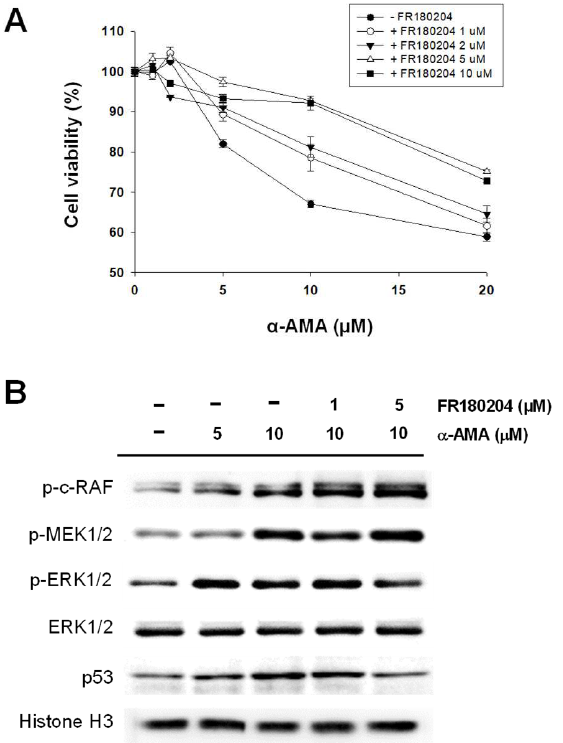
Figure 3. Identification of RAS/RAF/ERK signaling pathway related to the toxicity of α-amanitin (α-AMA) in Huh-7 cells. ( A ) Cell viability assay for α-AMA treatment with ERK1/2 inhibitor. Cell density was 5 × 10 3 cells/well in a 96-well plate. The viability of Huh-7 cells was detected by CCK-8 reagent after α-AMA and ERK1/2 inhibitor treatment for 24 h. The data are presented as the means ± SEM ( n = 3). ( B ) Immunoblotting assay of RAS/RAF/ERK cascade after α-AMA and ERK1/2 inhibitor (FR180204) treatment of Huh-7 cells.